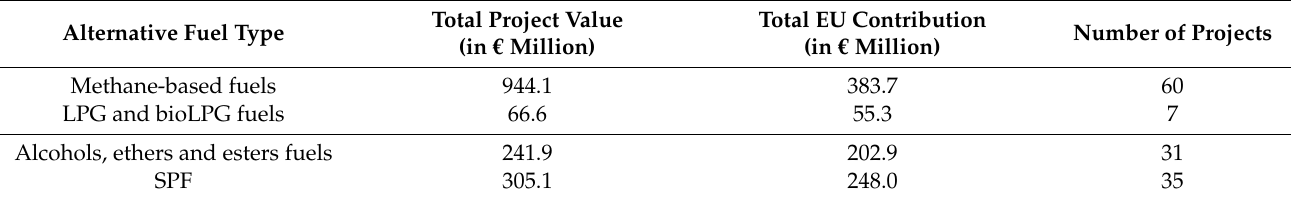
Table 2. Projects and levels of funding identified for transport